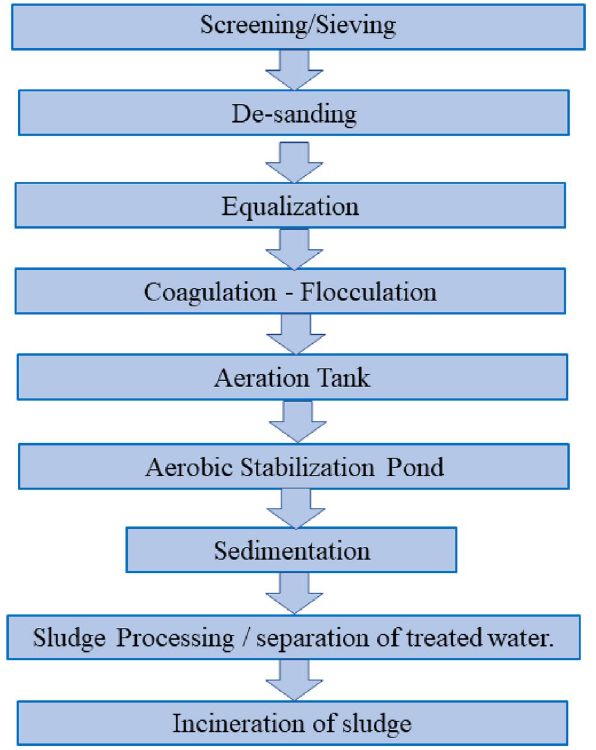
Fig. 2 The traditional wastewater treatment system in the textile industry (adapted from [17])